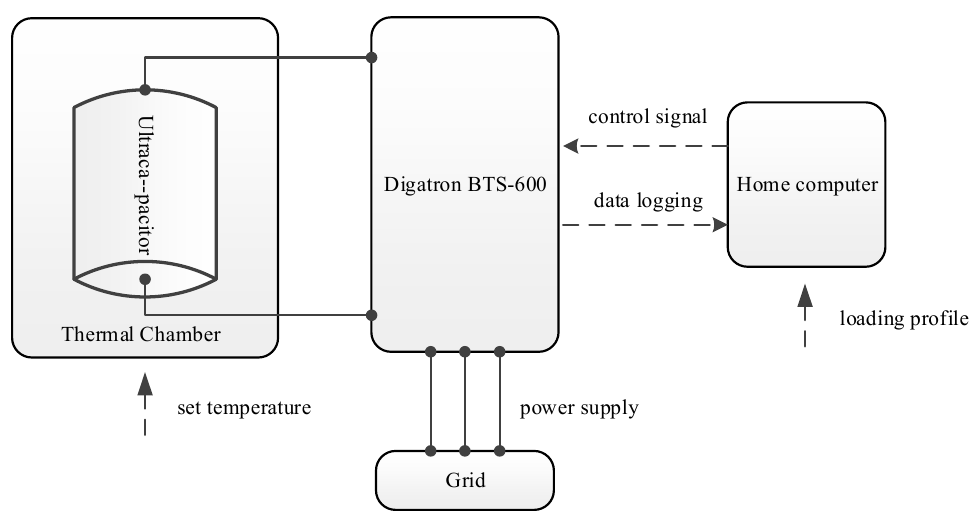
Figure 2. The block diagram of the test rig.